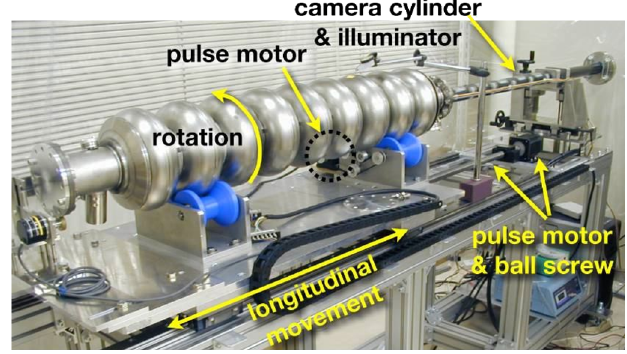
FIG. 3. (Color) Overview of our inspection